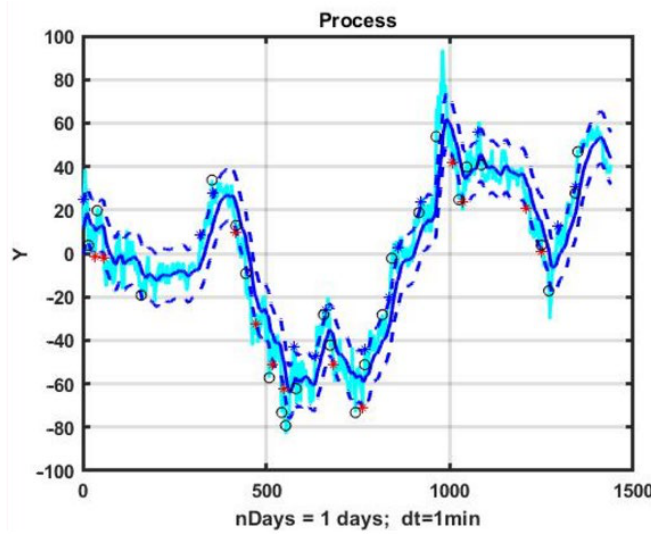
Figure 1. Example implementation of CSF on an observation interval of 1440 min counts.